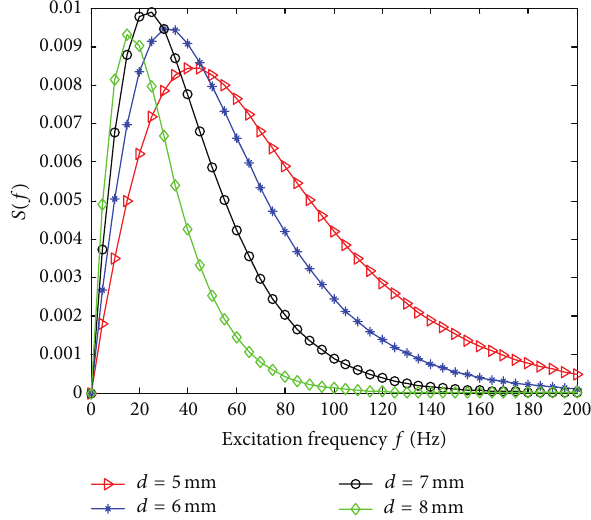
Figure 6: The curves of 𝑆(𝑓) under different